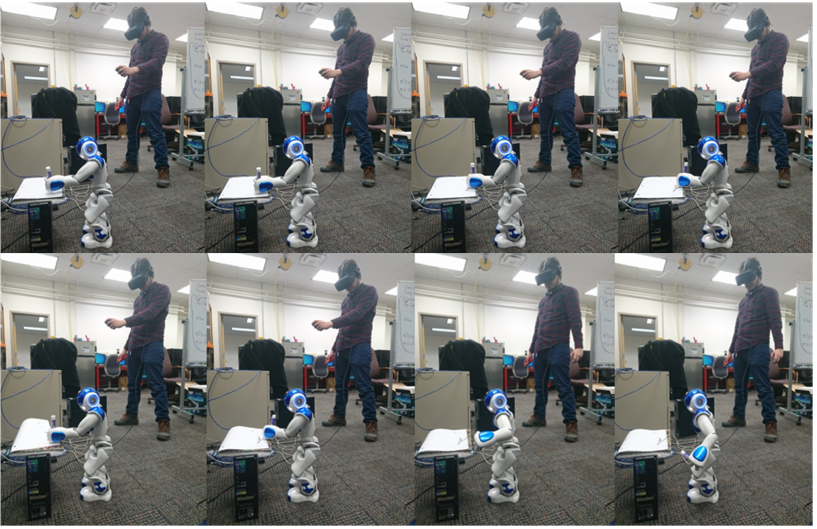
Figure 25. Result of marker manipulation with the NAO